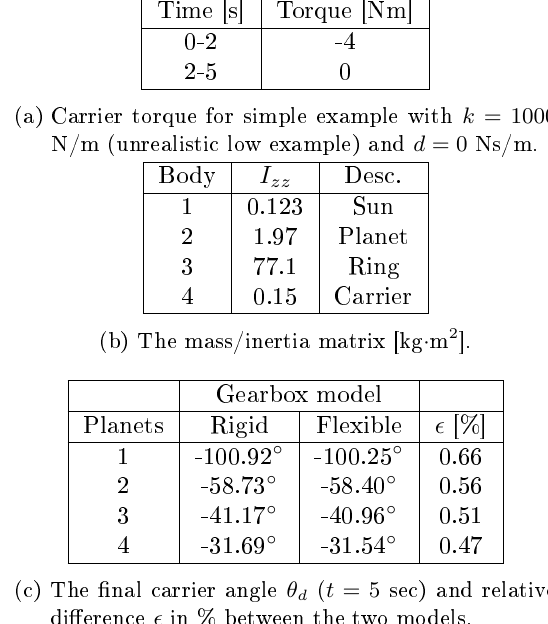
Table 1: Matlab input parameters, description of bod- ies and